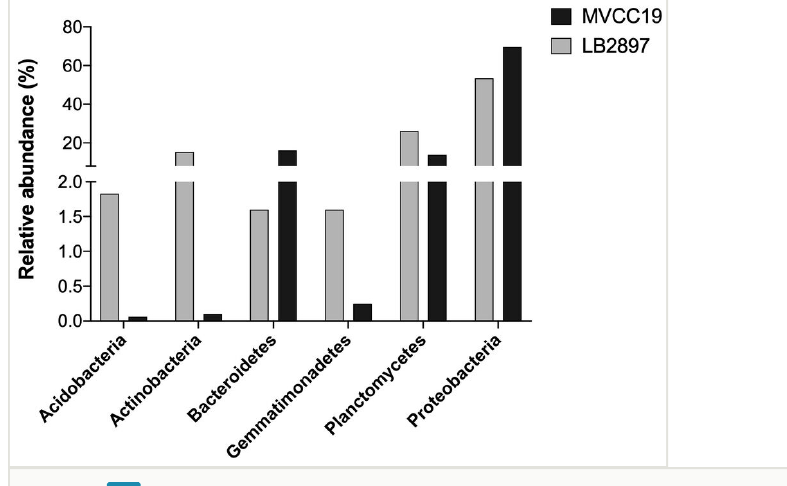
Relative abundance of bacterial phyla found in R. raciborskii microbiome from the SxP ecotype (MVCC19, black bars) and NoP ecotype (LB2897, grey